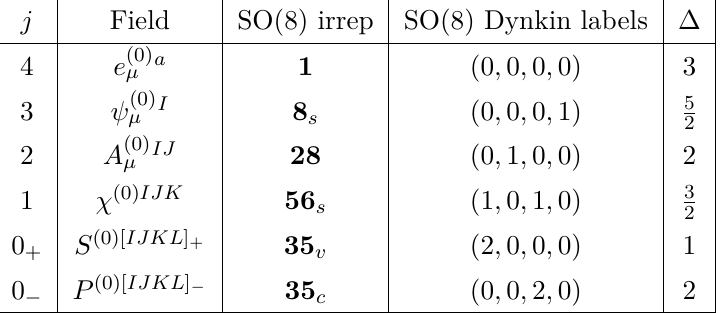
. We have indicated the 1